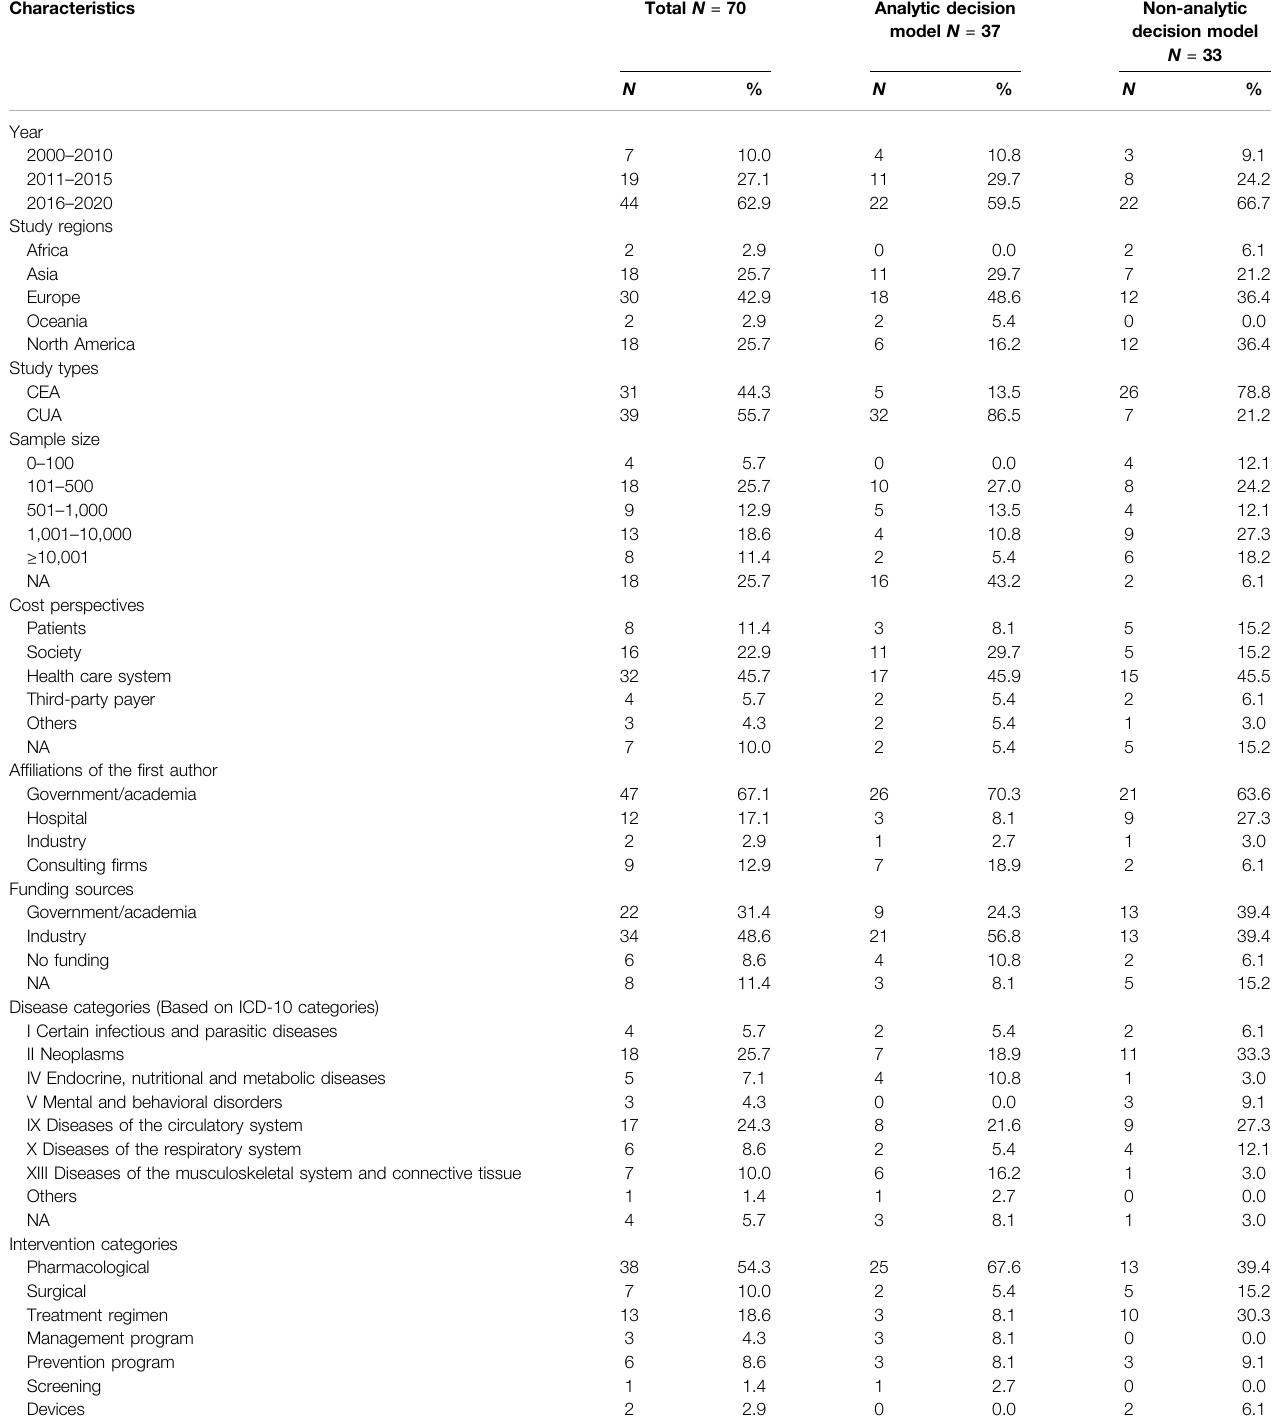
TABLE 1 | Characteristics of included